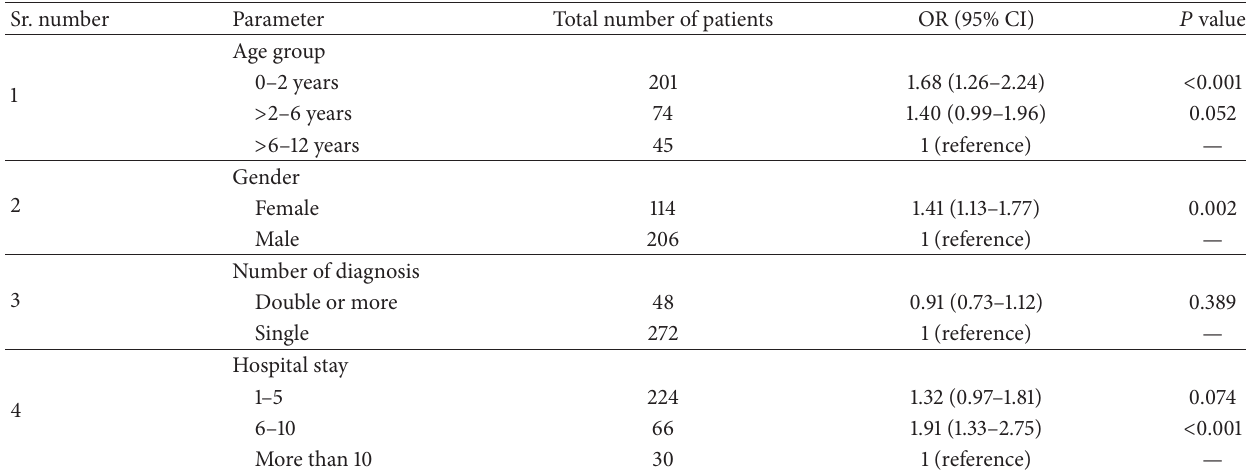
Table 5: Predictors of off-label medicine use (multivariate binary logistic regression model). Sr.